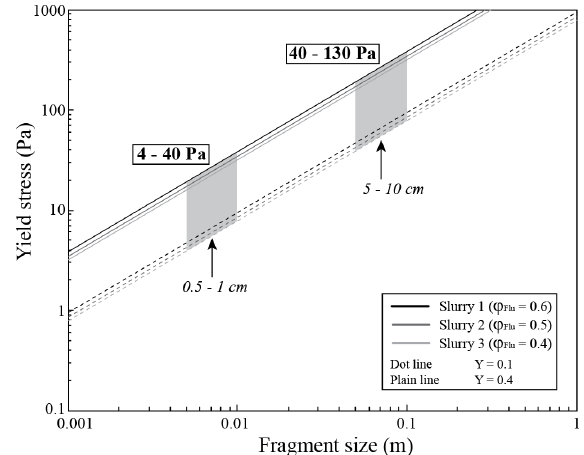
Figure 16. Modelled yield stress of three different slurries depend- ing on the size of the suspended country rock fragments. The yield stress is calculated from Eq. (2) (see text). Slurries 1 to 3 have a fluid fraction of 40, 50 and 60% respectively. A minimum value of 0.1 (dot line) and a maximum of 0.4 (plain line) are taken for the yield number. Results indicate that a yield stress of approximately 100Pa is required to prevent the sedimentation of decimetre blocks in the